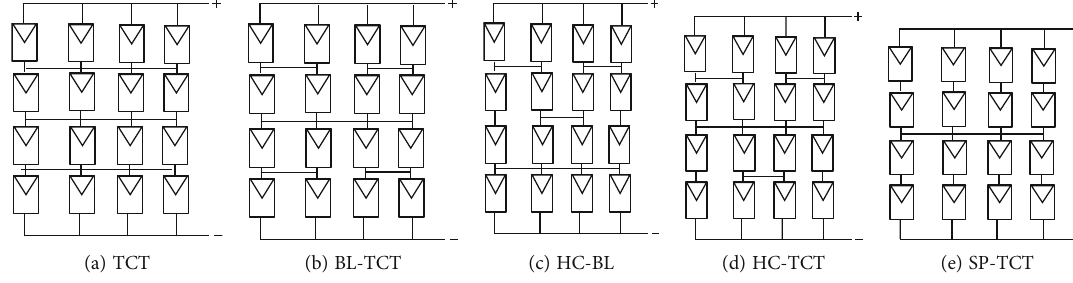
Figure 2: PV module topologies used for comparison.